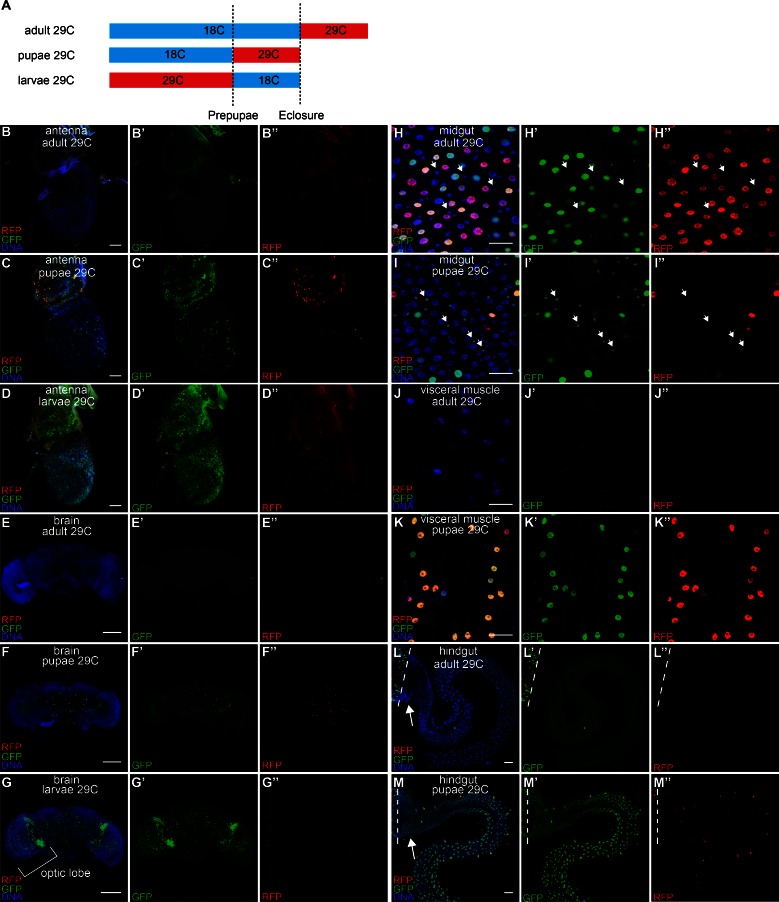
Developmental timing of caspase activation in adult tissues.(A) A schematic of the timing of the temperature shifts (blue: 18°C, red: 29°C) during the growth of flies with CasExpress, G-trace, and Gal80ts. (B–M) GFP and RFP expression in antenna (B–D), brain (E–G), midgut (H–I), visceral muscle surrounding midgut (J–K), and hindgut (L–M) in flies with CasExpress, G-trace, and Gal80ts that grown at the condition indicated in the panels. Panels marked with prime showed separated channels of the left. Arrows in H–I’’ point to some examples of GFP+ progenitor cells. Dotted lines in L–M’’ mark the boundary between midgut and hindgut. Arrows in L and M point to the hindgut proliferation zone. Scale bars in B–D, and H–M are 25 μm. Scale bars in E–G are 100 μm.